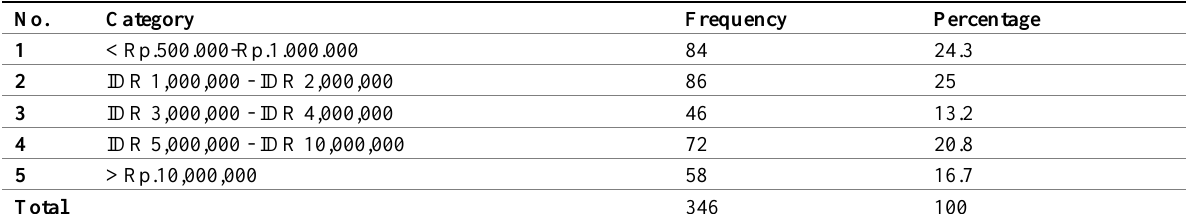
Table 7: Respondents' Income Level